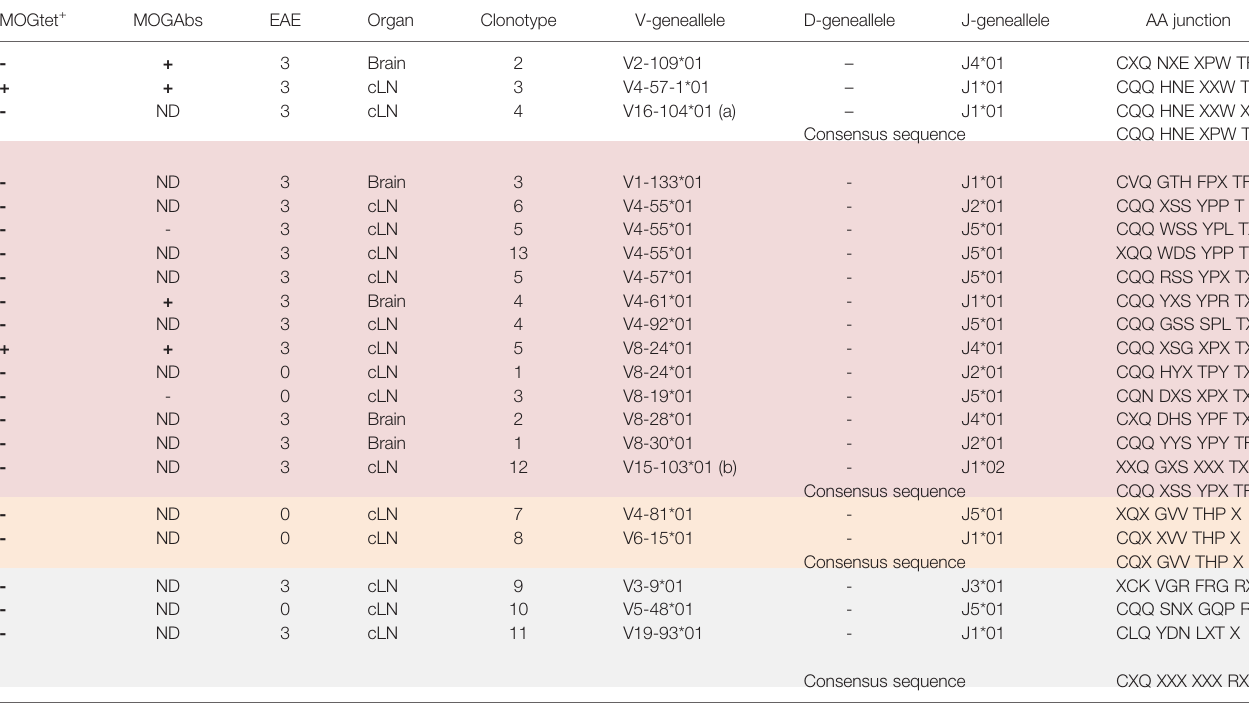
TABLE 2 | VJ rearrangements and junctional sequence of the kappa light chain of clonal iGB B cells. MOGtet + MOGAbs EAE